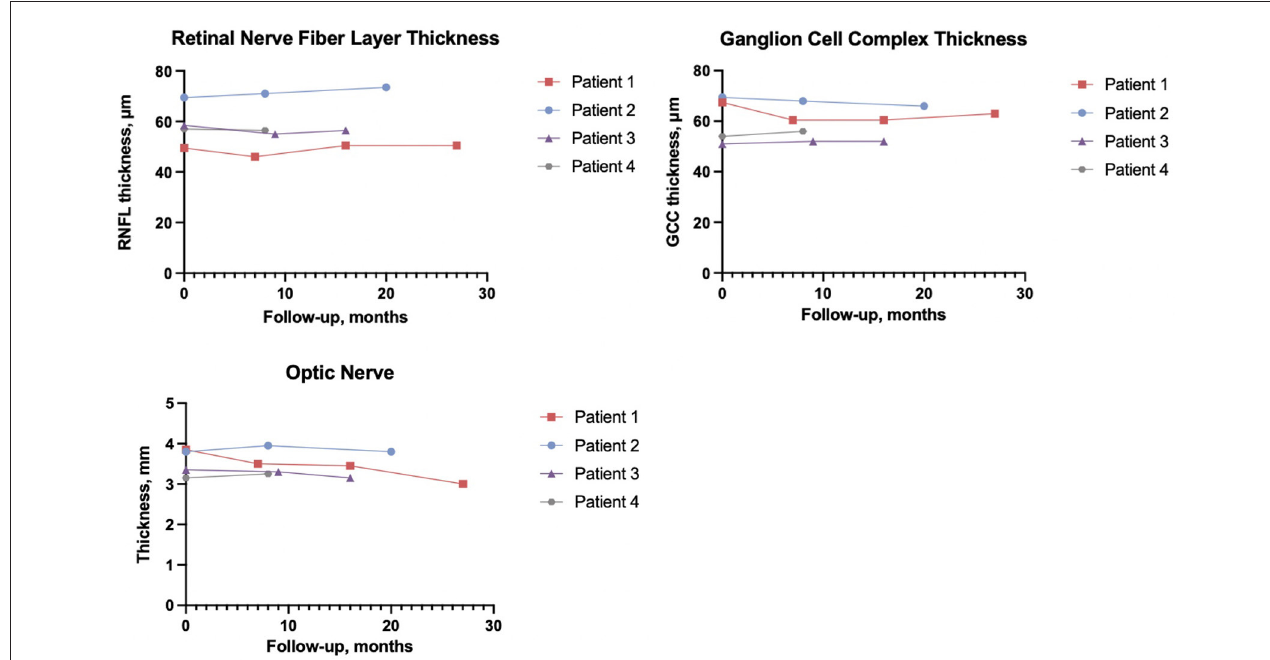
FIGURE 2 | Average retinal nerve fiber layer thickness, ganglion cell complex thickness, and average optic nerve thickness are of both